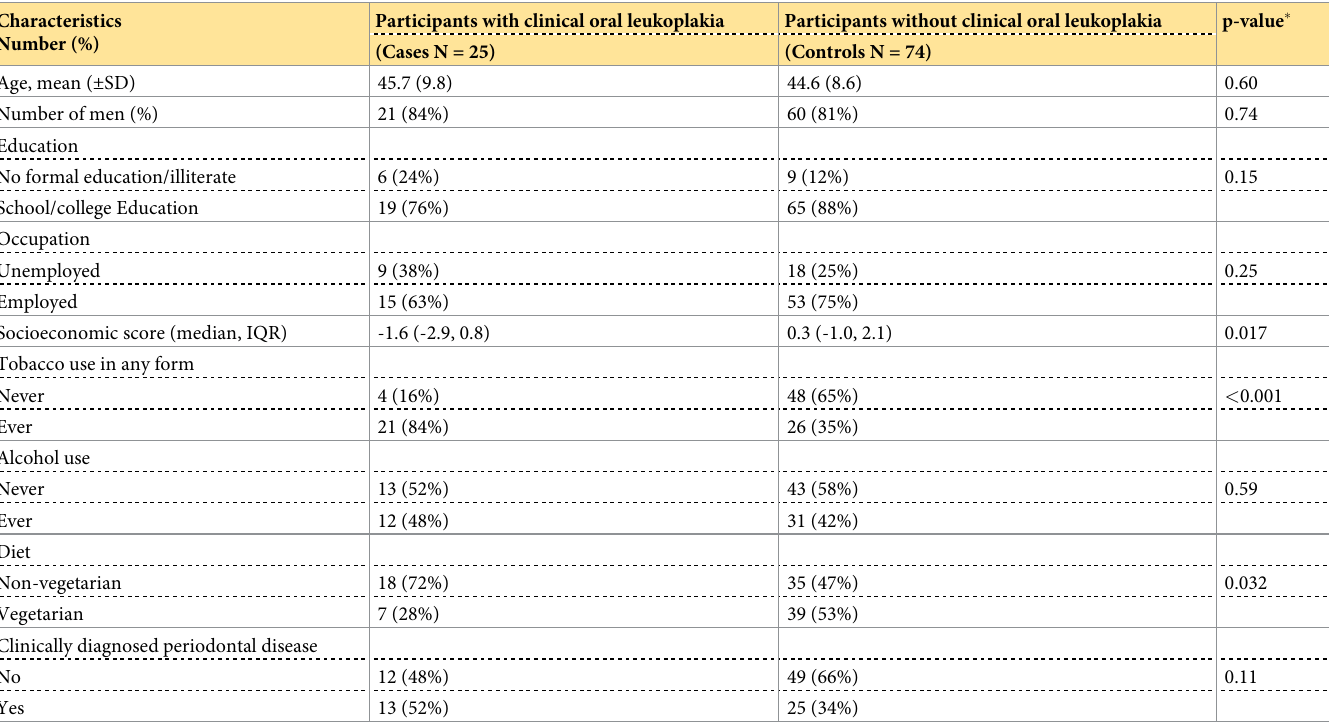
Table 1. Sociodemographics, life-style, medical and oral health characteristics of study participants with and without a clinical diagnosis of oral leukoplakia between 2014 and 2016 (N = 99). Characteristics Number